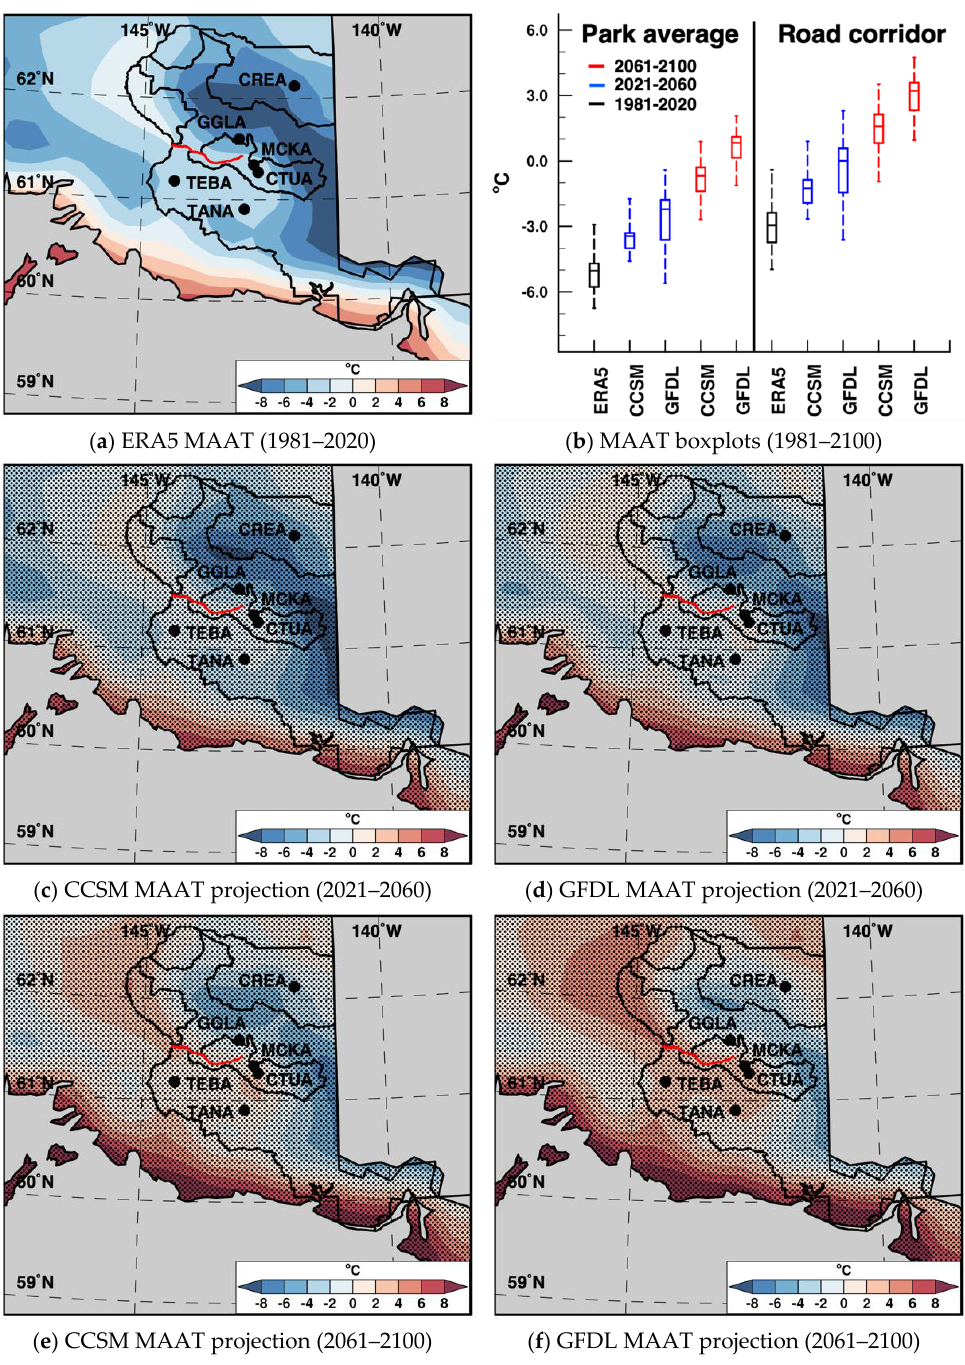
Figure 10. Wrangell-St. Elias ( a ) ERA5 mean annual air temperature (MAAT) climatology (°C), ( b ) park-average (left) and road corridor (right) boxplots of MAAT, and bias-corrected: mid-century MAAT projections from ( c ) CCSM and ( d ) GFDL and late-century MAAT projections from ( e ) CCSM and ( f ) GFDL. All projections are significant at the 95% confidence level (shaded with stippling).